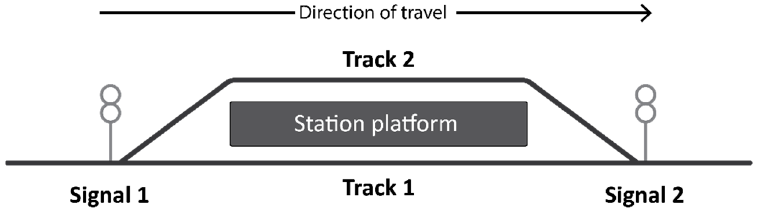
Figure 2. Schematic description of the location of data collection using signals. Adapted from [26].